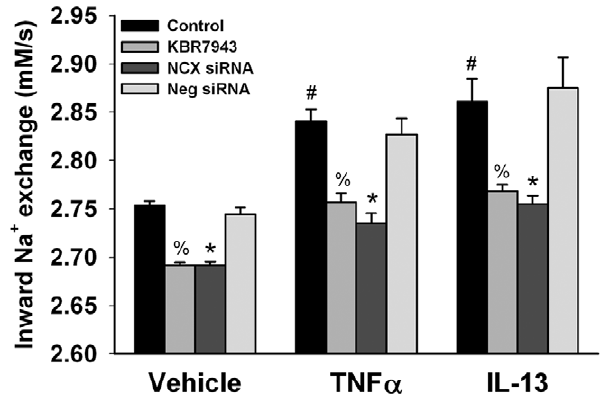
Figure 9. Effect of cytokines on inward Na + exchange via NCX in human ASM. In SBFI loaded ASM cells where this mode of NCX was evaluated using the protocol illustrated in Figure 7, TNF a or IL-13 significantly enhanced inward Na + exchange, while KBR7943 and NCX1 siRNA (but not negative siRNA) both significantly inhibited inward Na + exchange. Values are means 6 SE (n=5 patient samples for controls, 3 patient samples for cytokine groups; minimum 50 cells per bar). % indicates significant KBR7943 effect, * significant NCX1 siRNA effect, and # significant cytokine effect (p , 0.05).